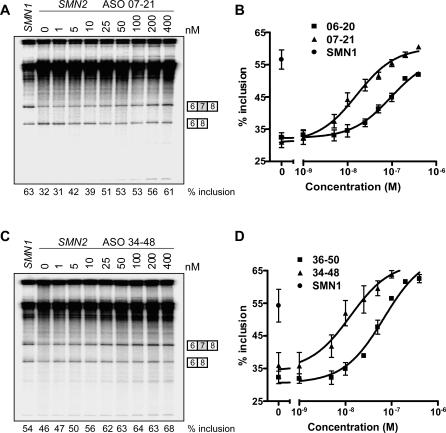
Dose-Response Analysis with the Two Improved ASOs Using In Vitro SplicingASOs 07–21 (A) and 34–48 (C) were tested at the indicated concentrations. In vitro splicing was carried out as in Figure 1. The percentage of exon 7 inclusion in each lane is indicated below each autoradiogram.(B) and (D) Sigmoidal curves were plotted to compare the dose-response effects of the high resolution–walk ASOs (A) and (C) with the initial-walk ASOs (from Figure 1) using the data from three independent experiments. The error bars show standard deviations.